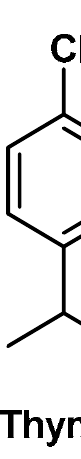
Figure 6. Chemical structure of thymol.